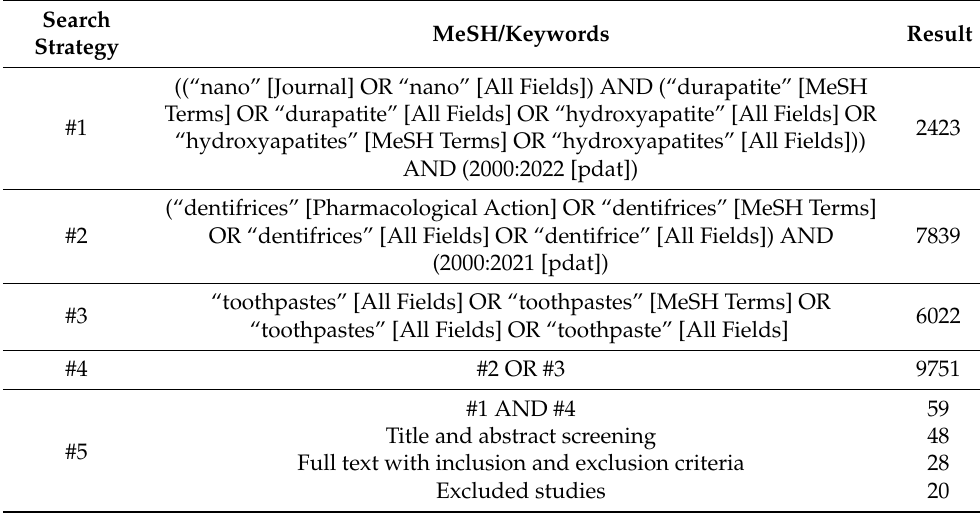
Table 1. Search Strategy for